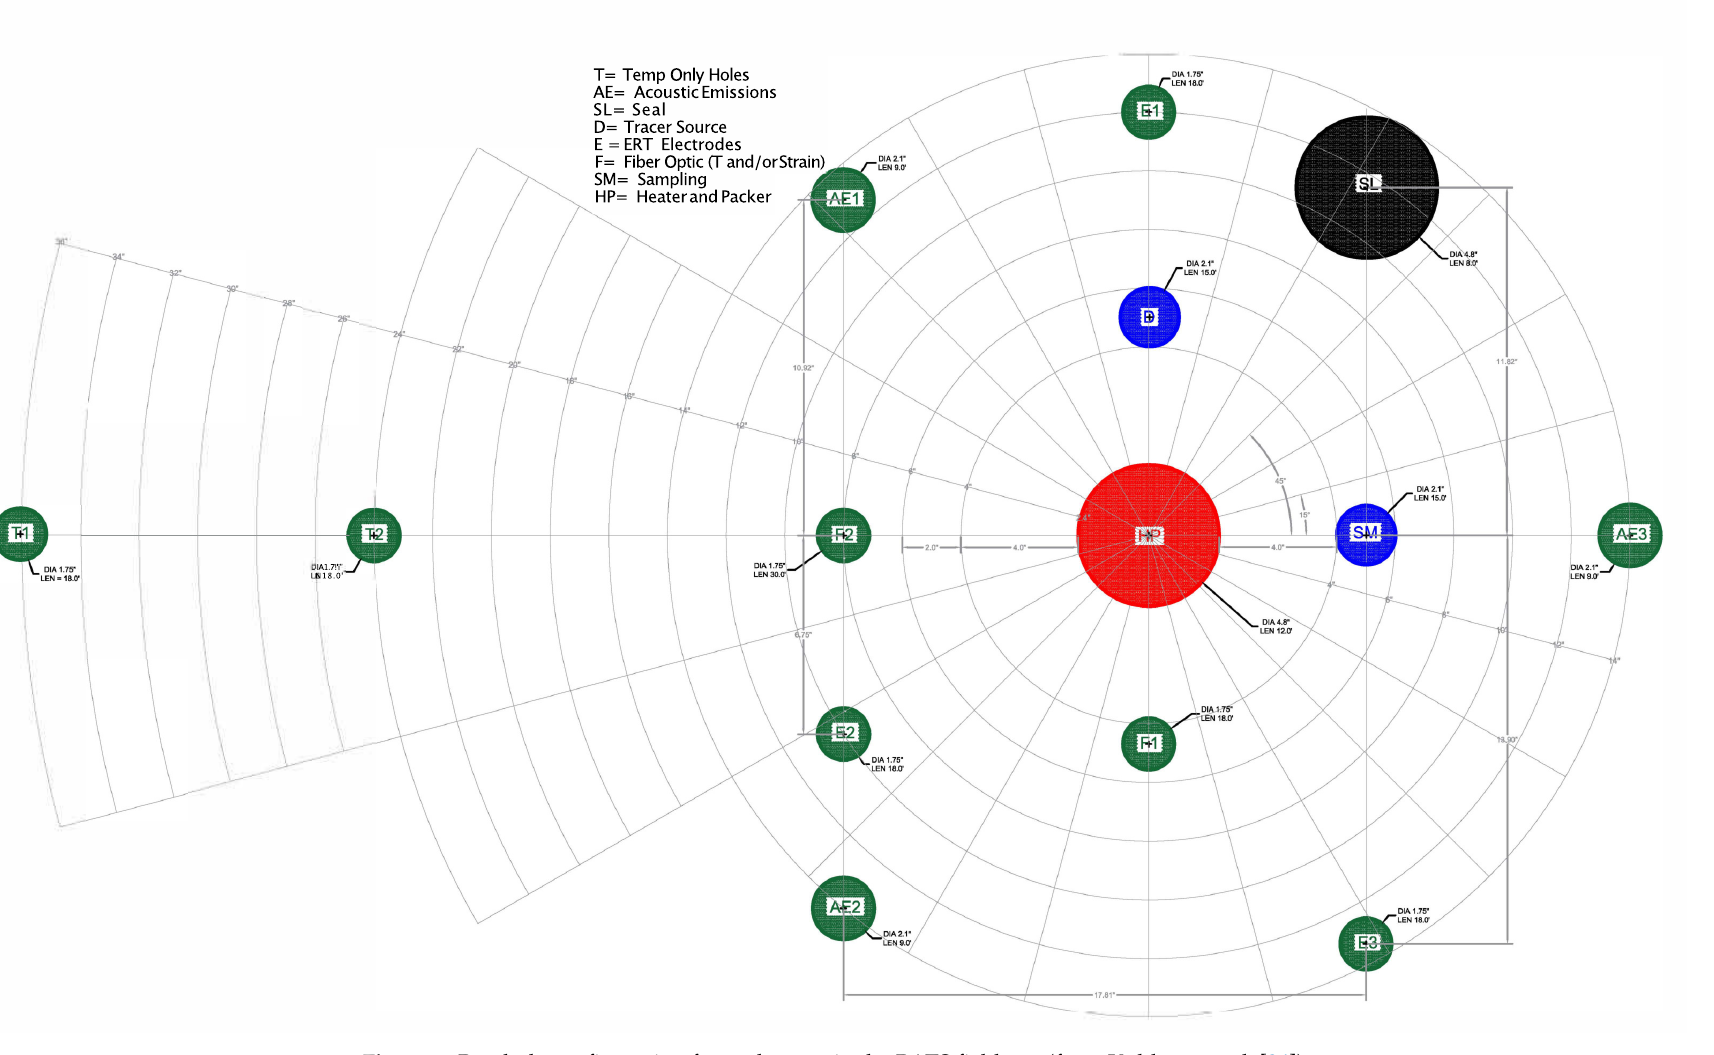
Figure 3. Borehole configuration for each array in the BATS field test (from Kuhlman et al.